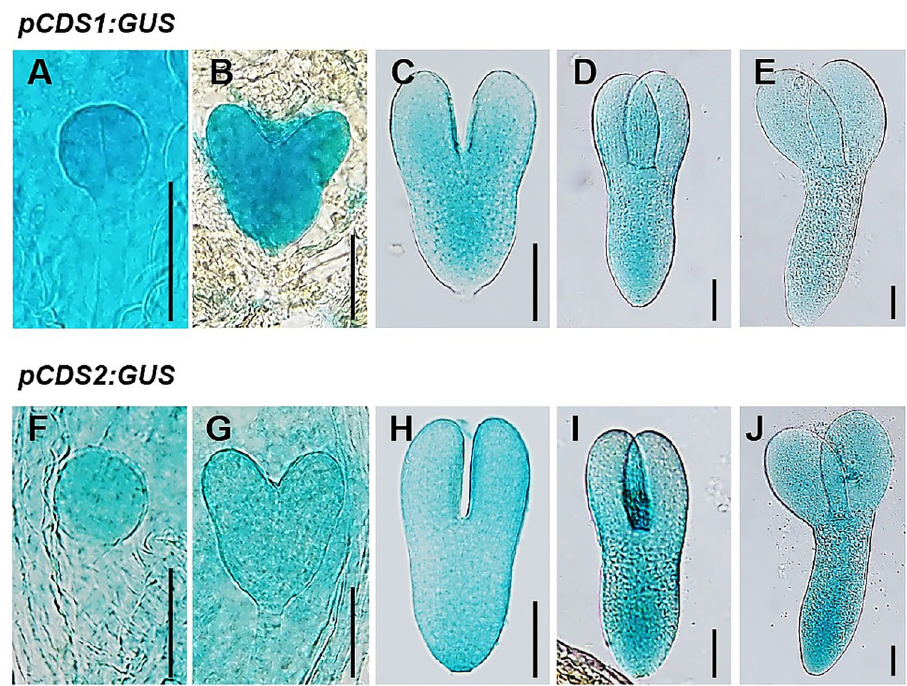
Fig 2. CDS1 and CDS2 genes are transcribed during Arabidopsis embryo development. Promoter-reporter gene (GUS) fusion study revealed that CDS1 and CDS2 were transcribed during Arabidopsis embryo development, including globular embryo (A, F), heart-shaped embryo (B, G), early torpedo embryo (C, H), late torpedo embryo (D, I) and cotyledon embryo (E, J). Representative images of three independent homozygous lines were shown. Bars = 50 μ